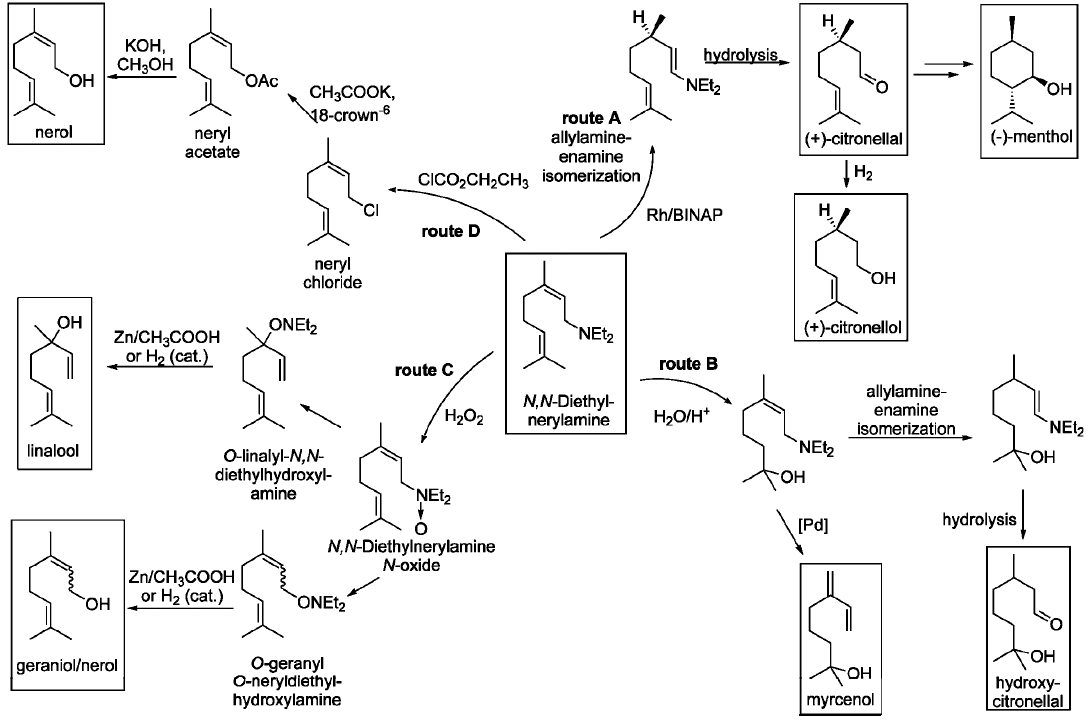
Figure 17. Product network based on N , N -diethylnerylamine. Reproduced from [33] with permission from Willey.